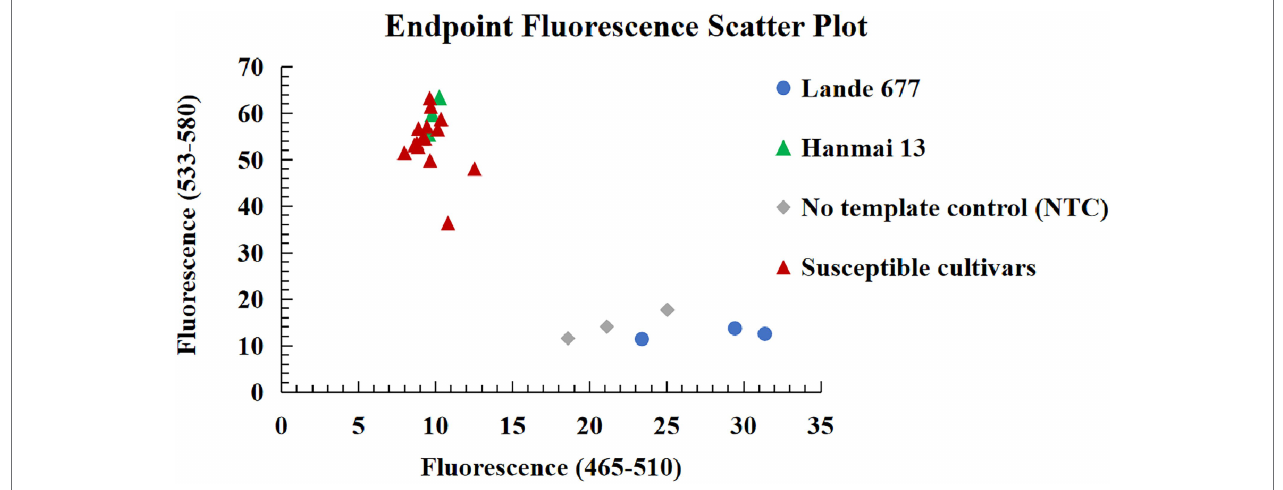
FIGURE 7 | Genotyping results of the Pm2 KASP marker YTU-KASP-Pm2 for Lande 677, Hanmai 13 and 15 susceptible wheat cultivars/breeding lines Shimai 22, Taimai 1918, Hanmai 13, Tainong 18, Shannong 15381, Taitianmai 118, Zhongxin 7503, Jimai 61, Huixianhong, Yannong 21, Shixin 633, Mingxian 169, Xinshiji 156, 12CA49, and Shi